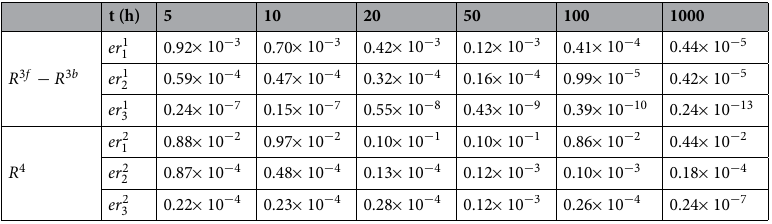
Table 5. Relative error in approximating ( R 3 f − R 3 b ) (top) and R 4 (bottom) at indicative points along the M = 2 period: TOP: via the QSSA expression in Eq. (5) ( er 1 1 ), the more accurate expression in Eq. (15) ( er 1 2 ) and the CSP expression in Eq. (35) ( er 1 3 ), BOTTOM: via the QSSA expression in Eq. (10) ( er 2 1 ), the more accurate expression in Eq. (21) ( er 2 2 ) and the CSP expression in Eq. (41) ( er 2 3